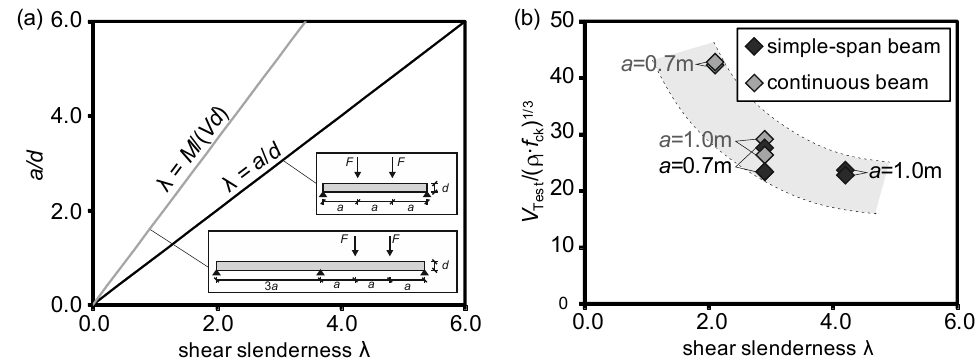
Figure 21. Relationship between shear slenderness λ and ( a ) a / d —ratio and ( b ) shear capacity of single-span and continuous beams (according to [77,78]).